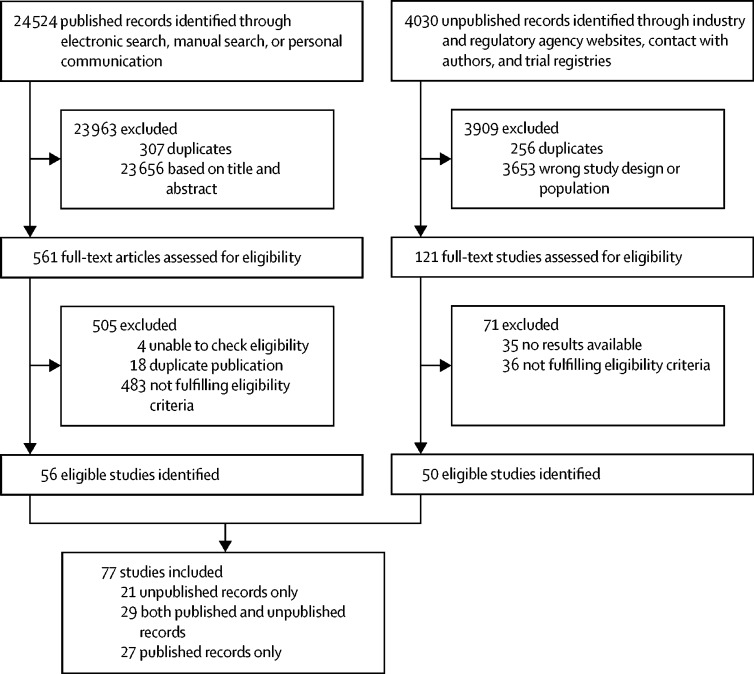
Study selection